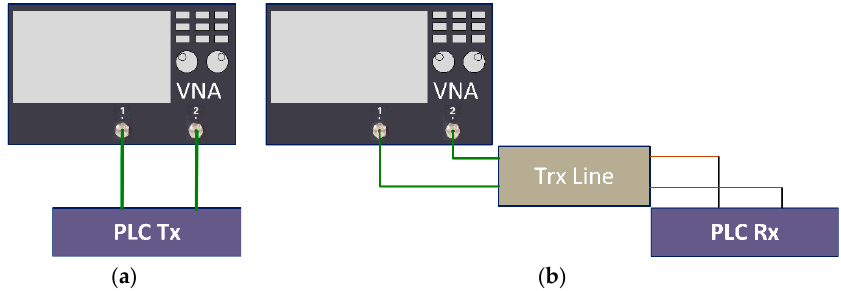
Figure 4. Characterization of ( a ) PLC Tx and ( b ) PLC Rx and transmission line.